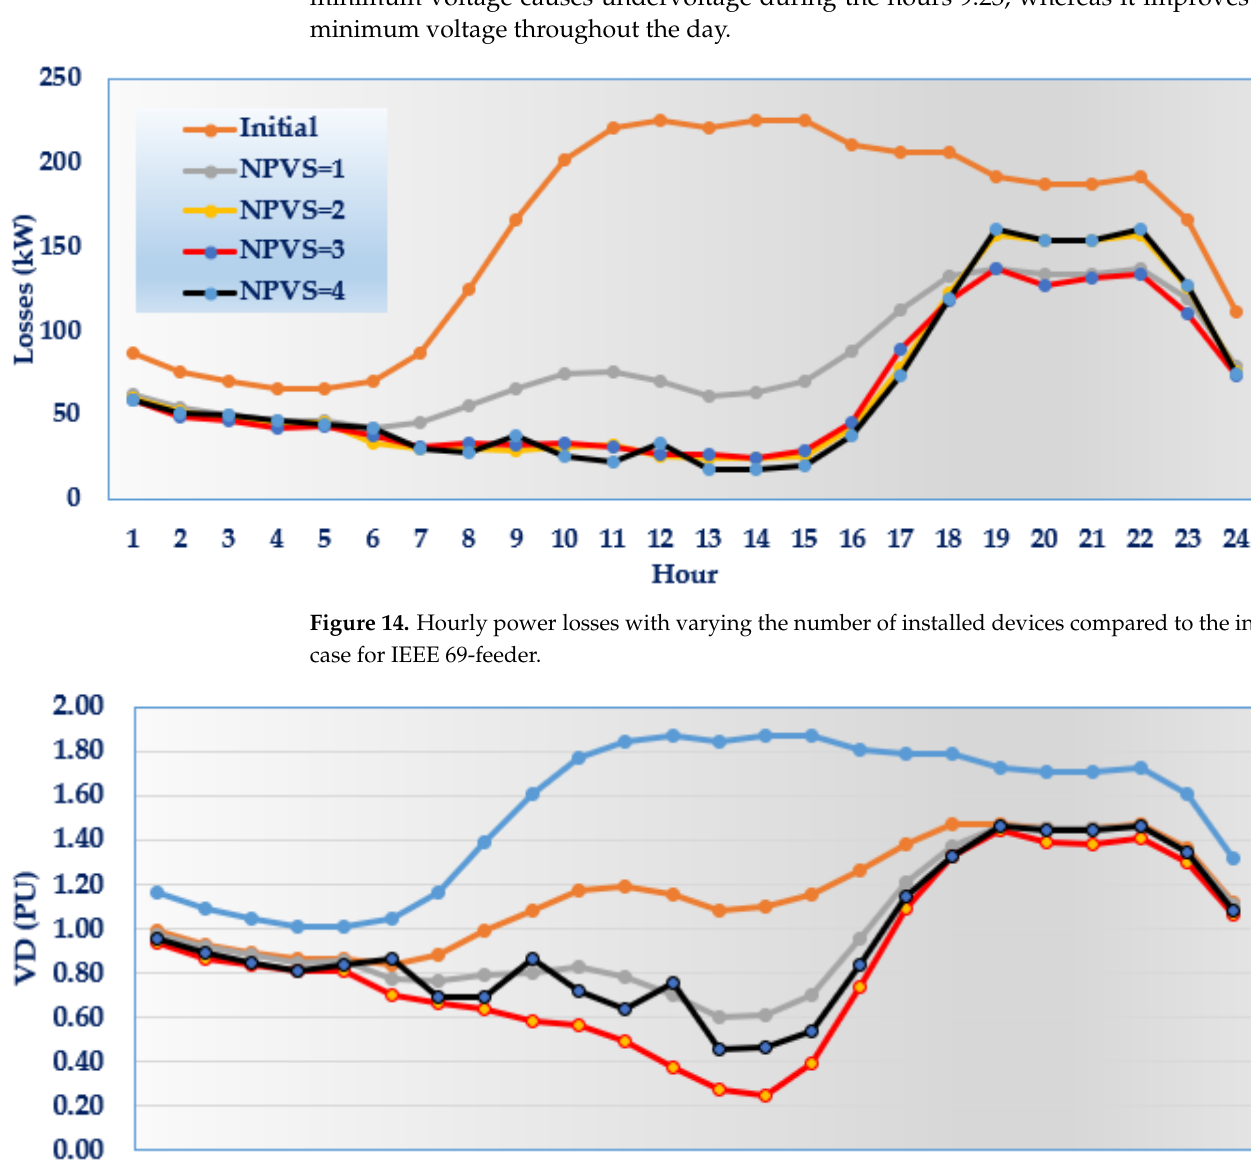
Figure 15. Hourly voltage deviations with varying the number of installed devices compared to the initial case for IEEE 69-feeder.